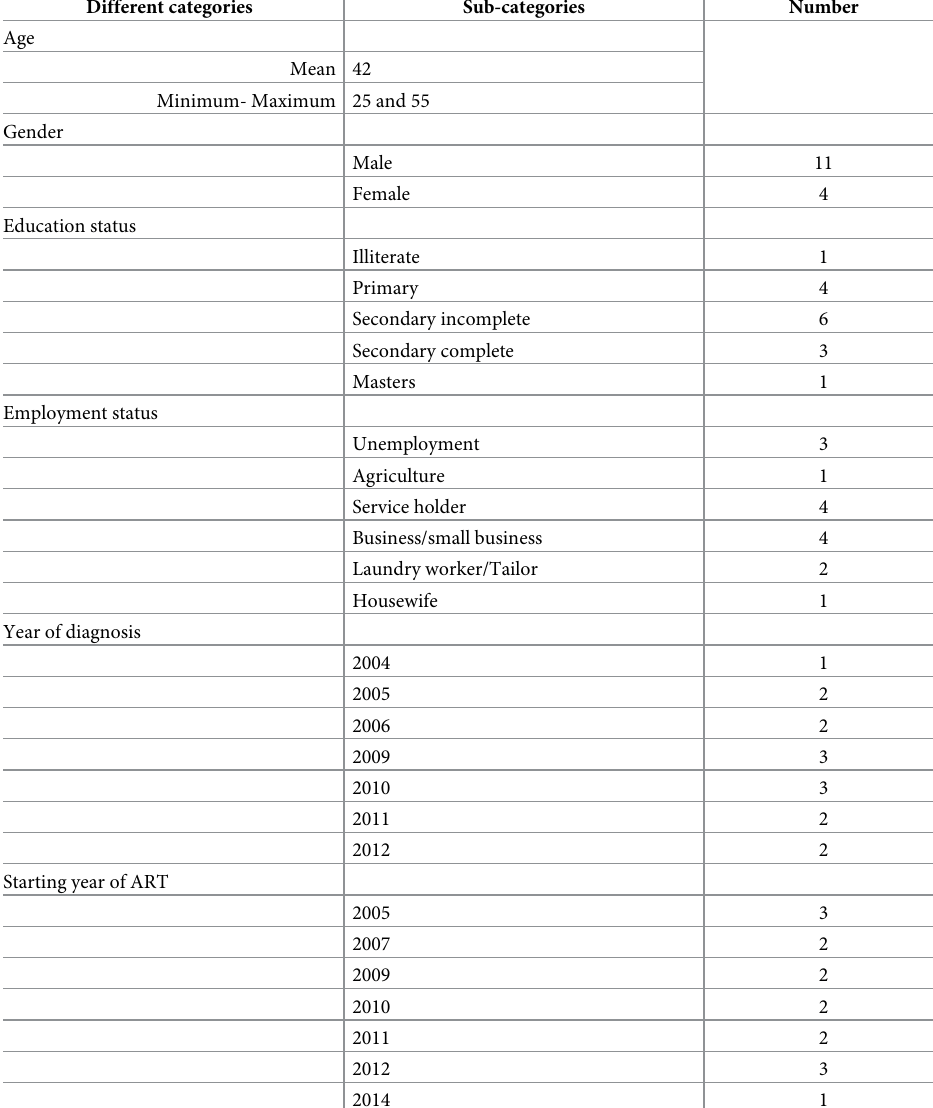
Table 1. Summary profile of the study